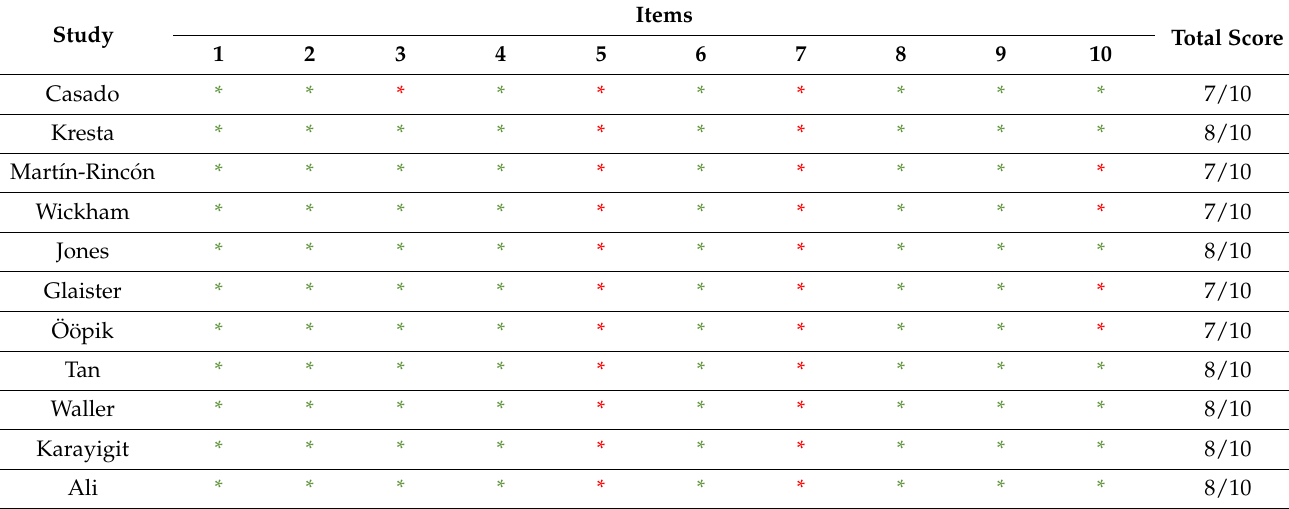
Table 2. Risk of bias scores according to the PEDro